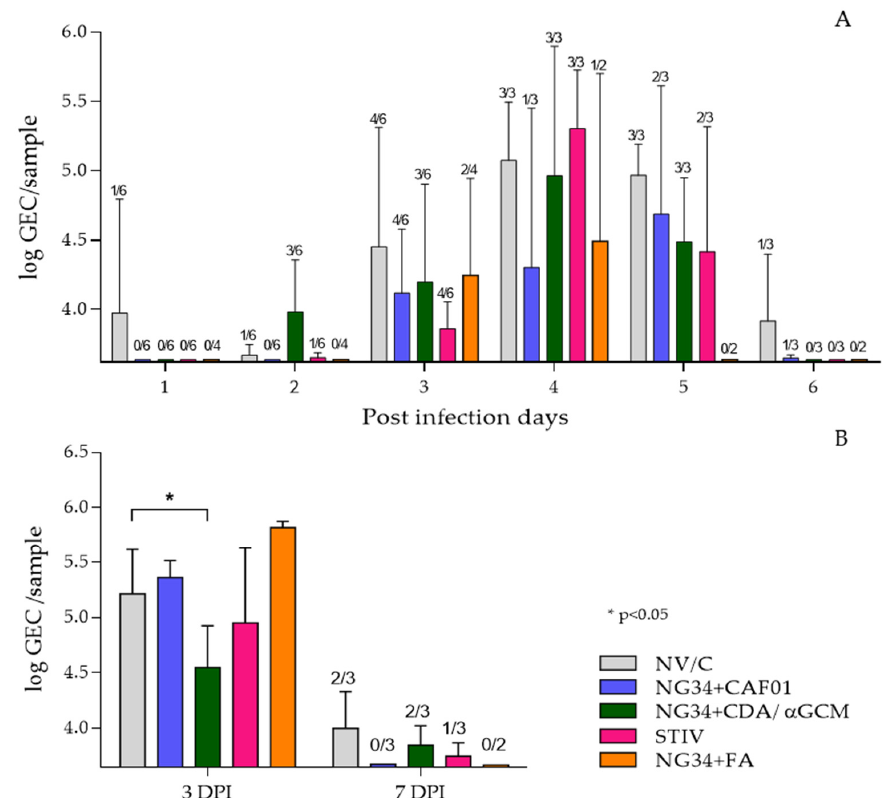
Figure 2. Results obtained by RTqPCR analysis from nasal swabs ( A ) and bronchoalveolar lavage ( B ). Viral load in nasal swabs is represented as log GEC/sample of Influenza M protein gene from purified RNA of nasal swabs or BALF. Bars express averages and error bars the SD of each group. The number of animals with positive signal in qRT-PCR are represented above each bar in the figure.